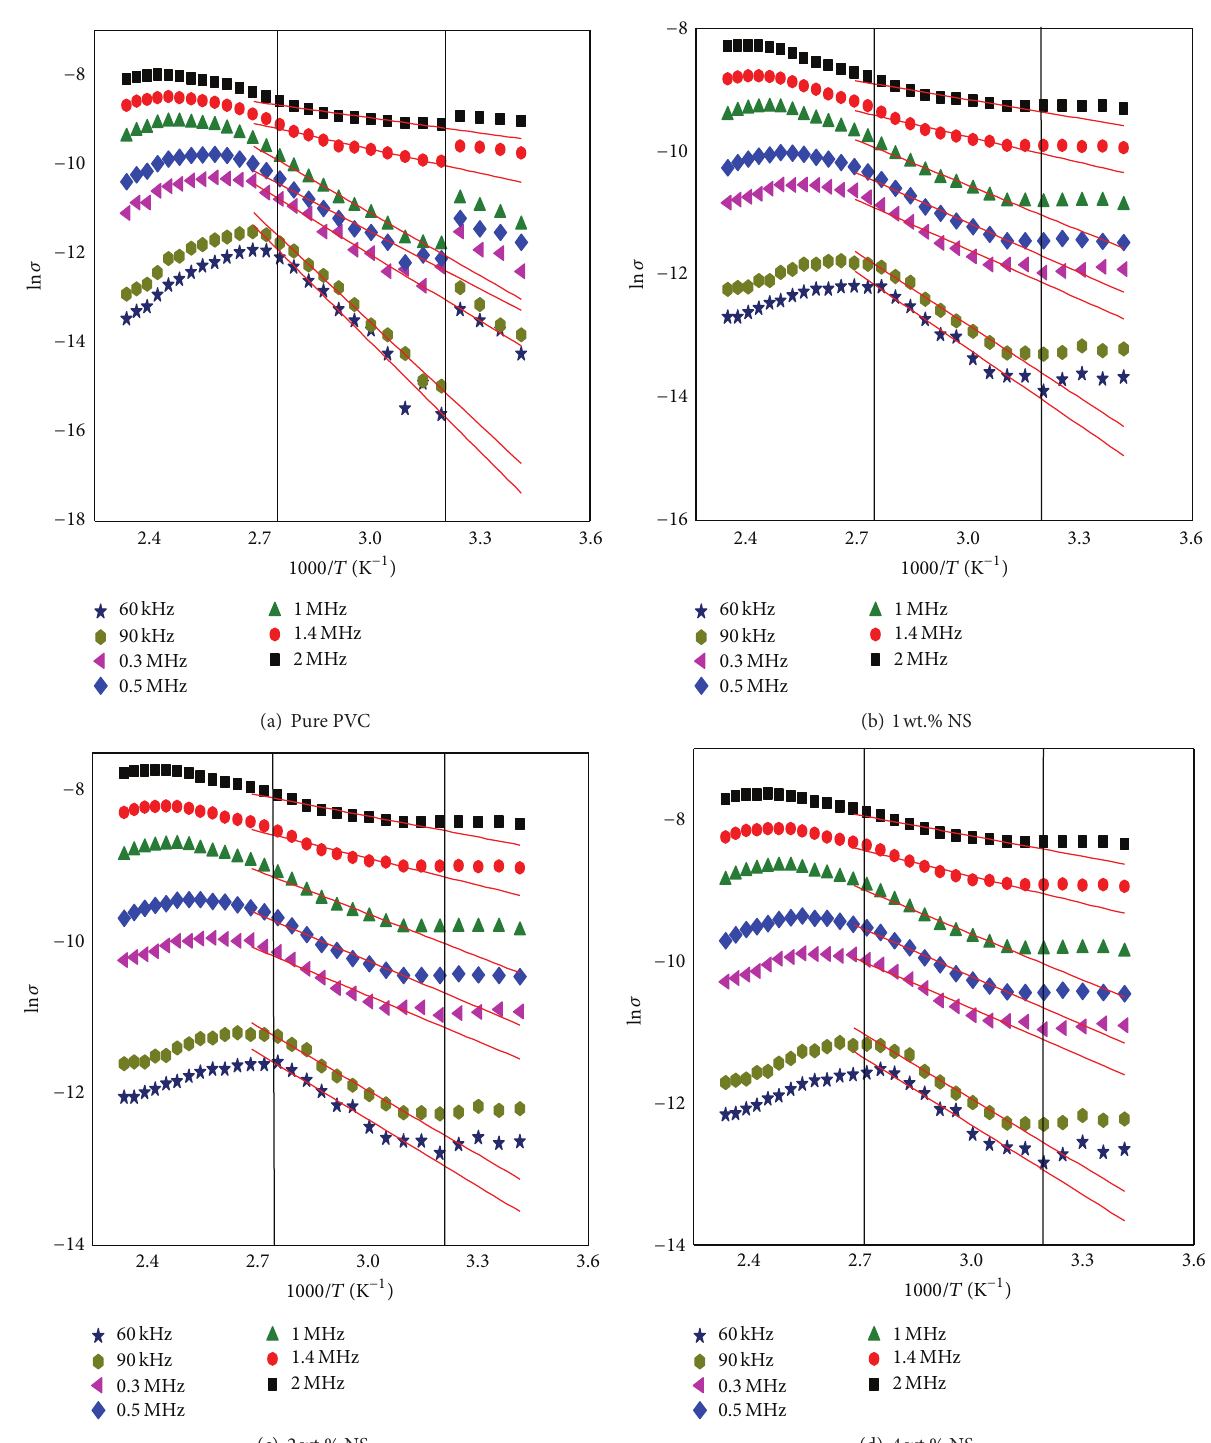
Figure 12: The variation of AC conductivity for pure PVC and PVC-SiO 2 nanocomposite films with temperature at different